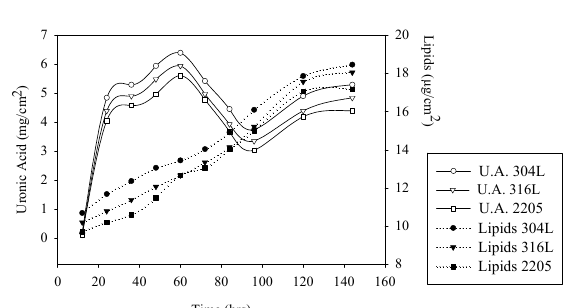
Fig. 3 Corelation in conc. of uronic acid and lipids of EPS with time on stainless steels with bacteria during immersion tests without media replenishing